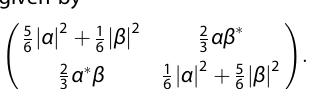
Fig. 2 Reconstructed output states of Q 2 and Q 3 for the six input states. a 0 1 j i ; b 0 1 j i þ i 1 1 j ið Þ = ffiffiffi p e 0 1 j i (cid:2) 1 1 j ið Þ = 2 ; f 1 1 j i . The measured output density matrices of Q 2 and Q 3 are respectively displayed in the upper and lower panels. Each matrix element is characterized by two color bars, one for the real part and the other for the imaginary part. The black wire frames denote the